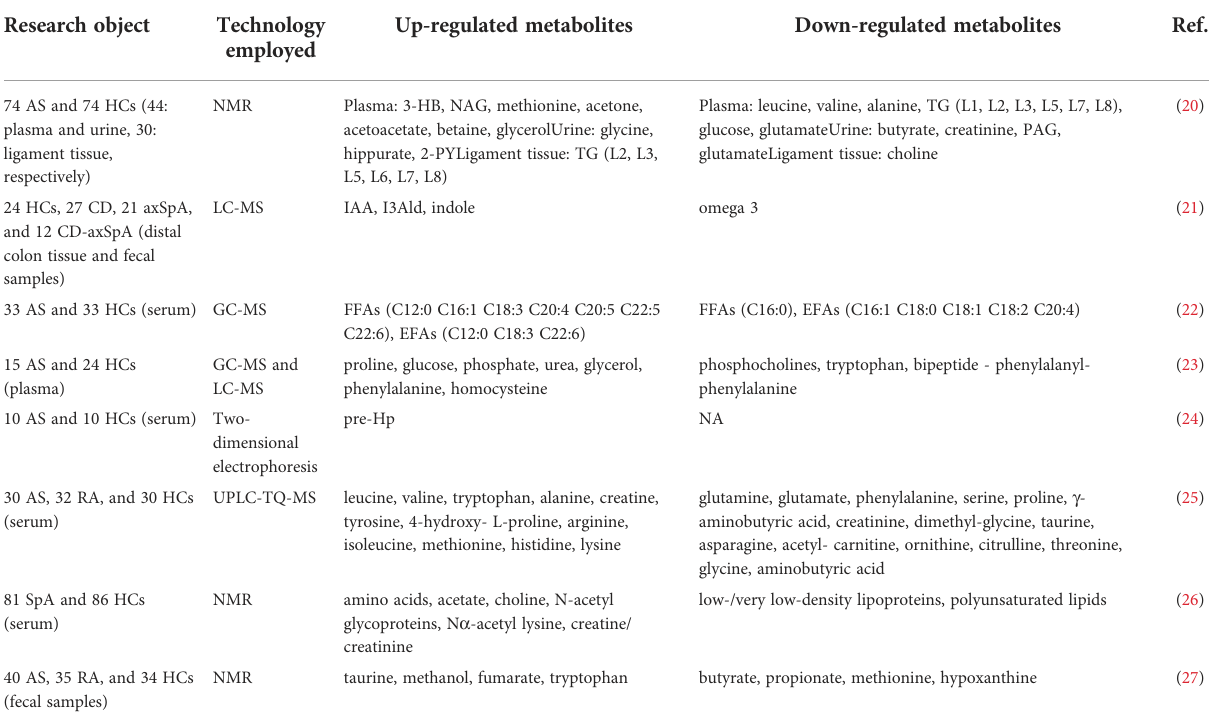
TABLE 2 Altered metabolites in AS